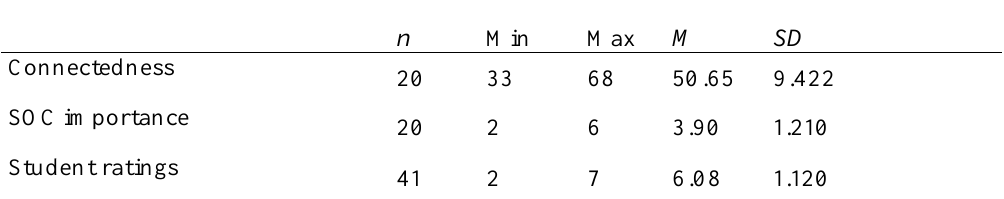
Descriptive Statistics for Iteration 3